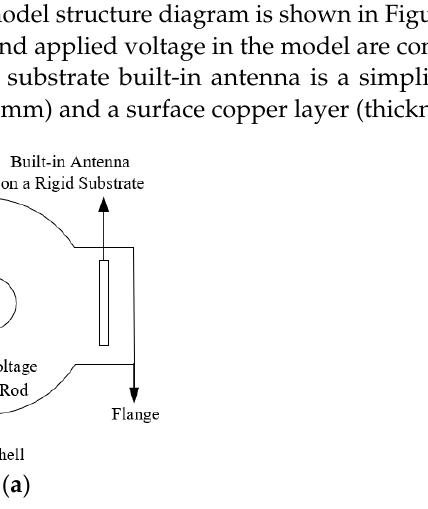
Figure 12a. The real GIS shell (bending radius 325 mm) is set as grounding in the model,